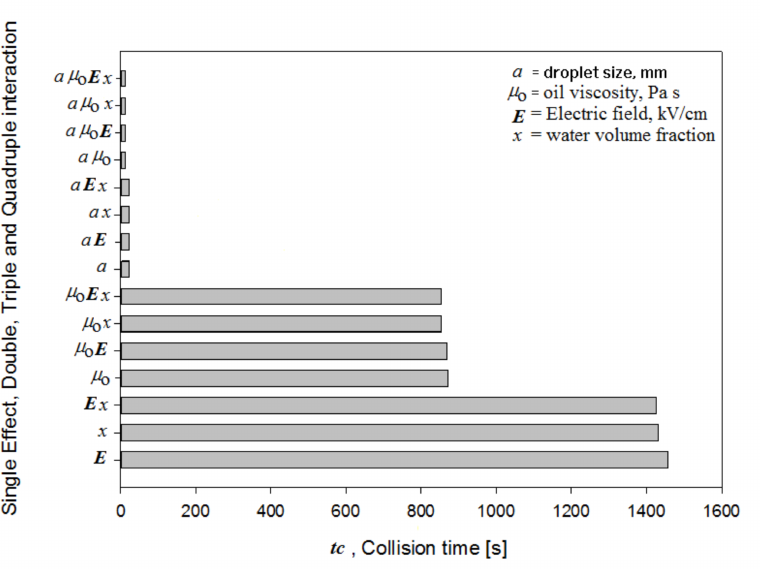
Figure 7. Pareto chart of the single, double, triple and quadruple interaction effects on the collision time, t (s), the significance level is α =